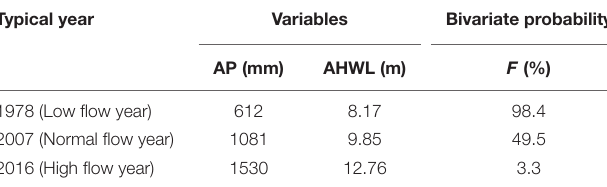
TABLE 1 | Characteristic statistics of typical